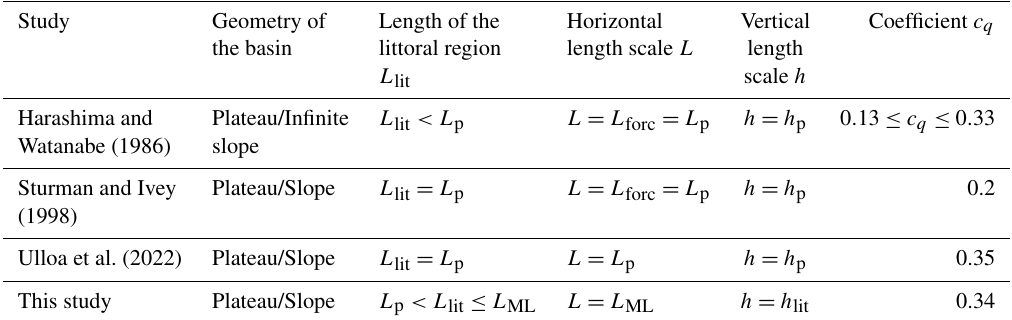
Table 2. Comparison of the transport scaling formula q = c q h(B 0 L) 1 / 3 between different studies on sloping basins, where h is a vertical length scale, and L is a horizontal length scale. The different notations can be found in Fig. 1 and Table 1. The littoral region is based on the location of the discharge measurement, as in Fig. 1. L forc is the length over which the destabilizing forcing B 0 applies. Study Geometry of Length of the Horizontal Vertical Coefficient c q the basin littoral region length scale L length L lit scale h Harashima and Plateau/Infinite L lit < L p L = L forc = L p h = h p 0 . 13 ≤ c q ≤ 0 . 33 Watanabe (1986) slope Sturman and Ivey Plateau/Slope (1998) Ulloa et al. (2022)